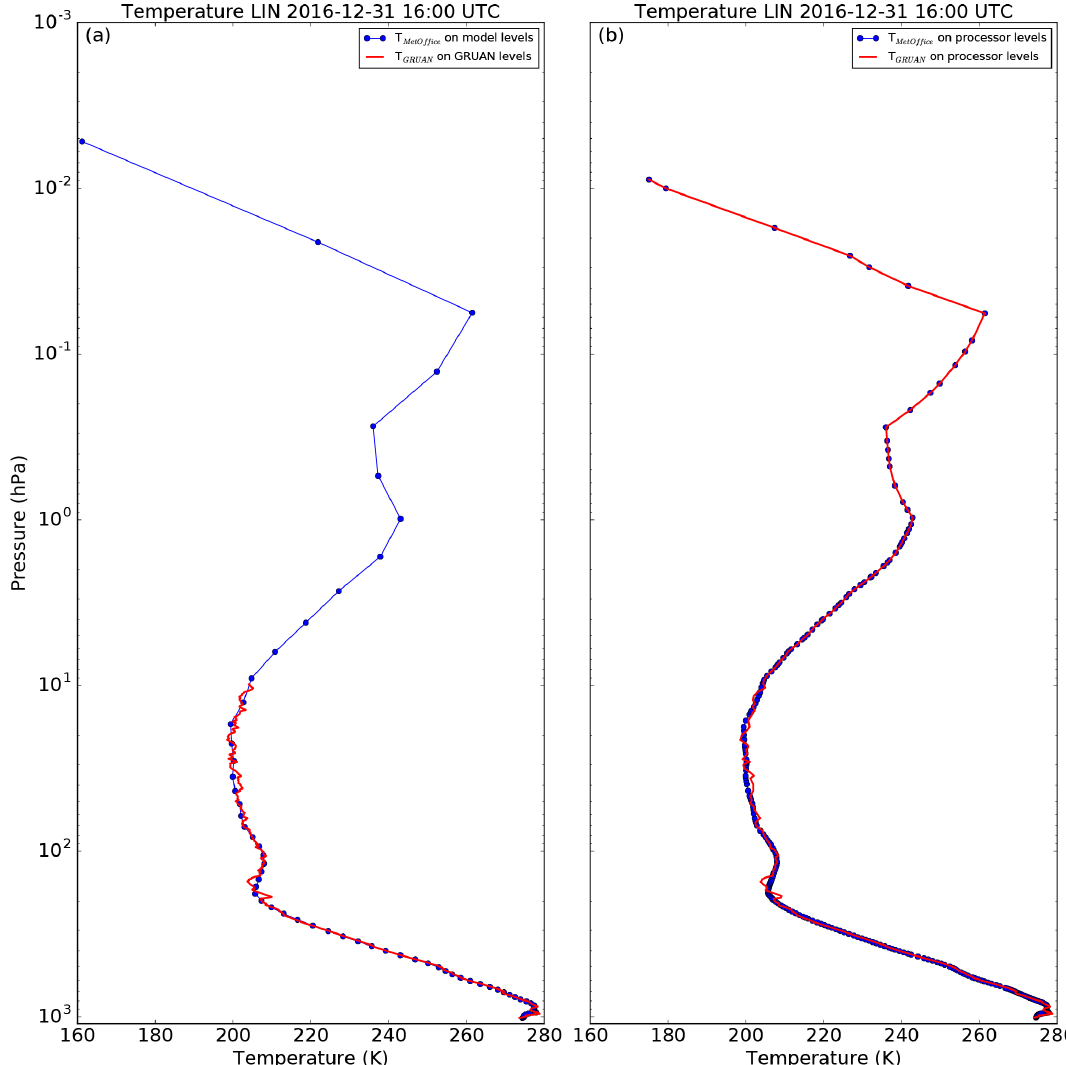
Figure 3. (a) GRUAN temperature profile (red line) from Lindenberg on 31 December 2016 at 16:00UTC as provided in the RS92-GDP data file with full GRUAN vertical resolution and a collocated Met Office temperature profile (blue dotted line) on the model vertical levels. (b) GRUAN temperature profile subsampled at the processor 278 pressure levels and merged with the Met Office profile above 9.8hPa (red line) and collocated Met Office temperature profile interpolated on the processor vertical levels (blue dotted